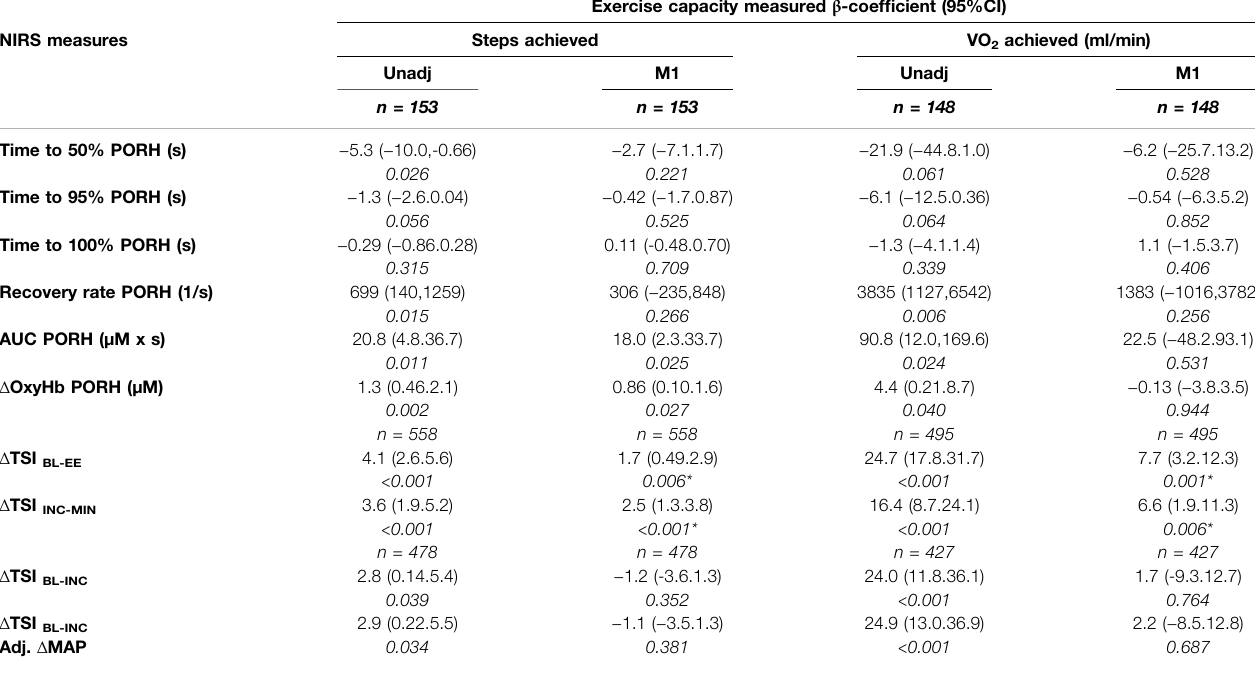
TABLE 3 | Associations between exercise capacity measures (steps achieved and measured V _ O 2 ) and indices of post-occlusive reactive hyperaemia (PORH); or tissue saturation index (TSI); changes during exercise measured in the lower-limb. Δ TSI BL-EE is the change in TSI, between rest (baseline, BL) and the end of exercise (EE); Δ TSI Δ TSI INC-MIN isthechangeinTSIfromitshighest pointattheINC, increment; toitsMIN,minimum; BL-INC isthechangeinTSIfromtheBLtothehighestpoint (INC).unadj, Unadjusted; and adjusted β -coef fi cients, 95% con fi dence intervals and p -values are presented for each association. M1, Model 1; is adjusted for age, sex and ethnicity. AssociationsbetweenPORHmeasuresandexercisecapacitywerealsoadjustedforheightandischaemicdurationinM1.*indicatesmodelsalsoadjustedforestimated workload